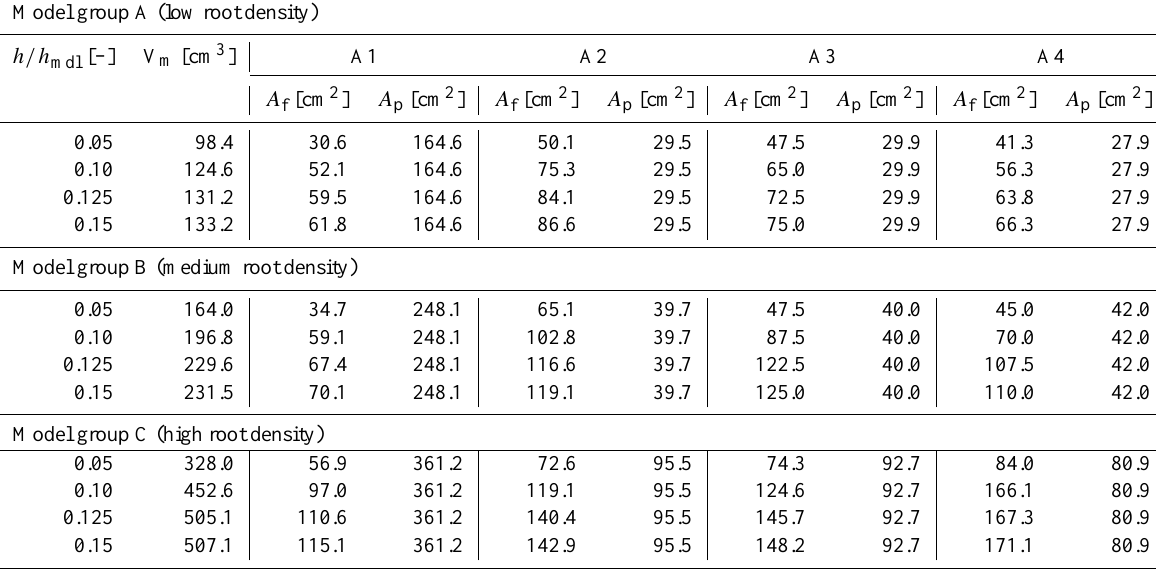
Table 1. Influence of model submergence depth on the parameters of “real” and parameterized mangrove models (scale 1 : 20) (see also Fig. 2). Model group A (low root density)